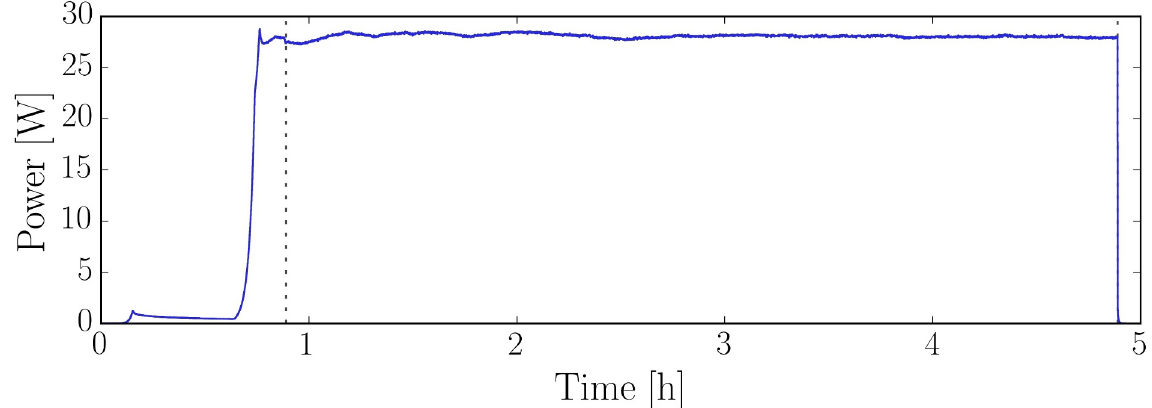
Figure 2: Power during the irradiation monitored with a fission chamber.